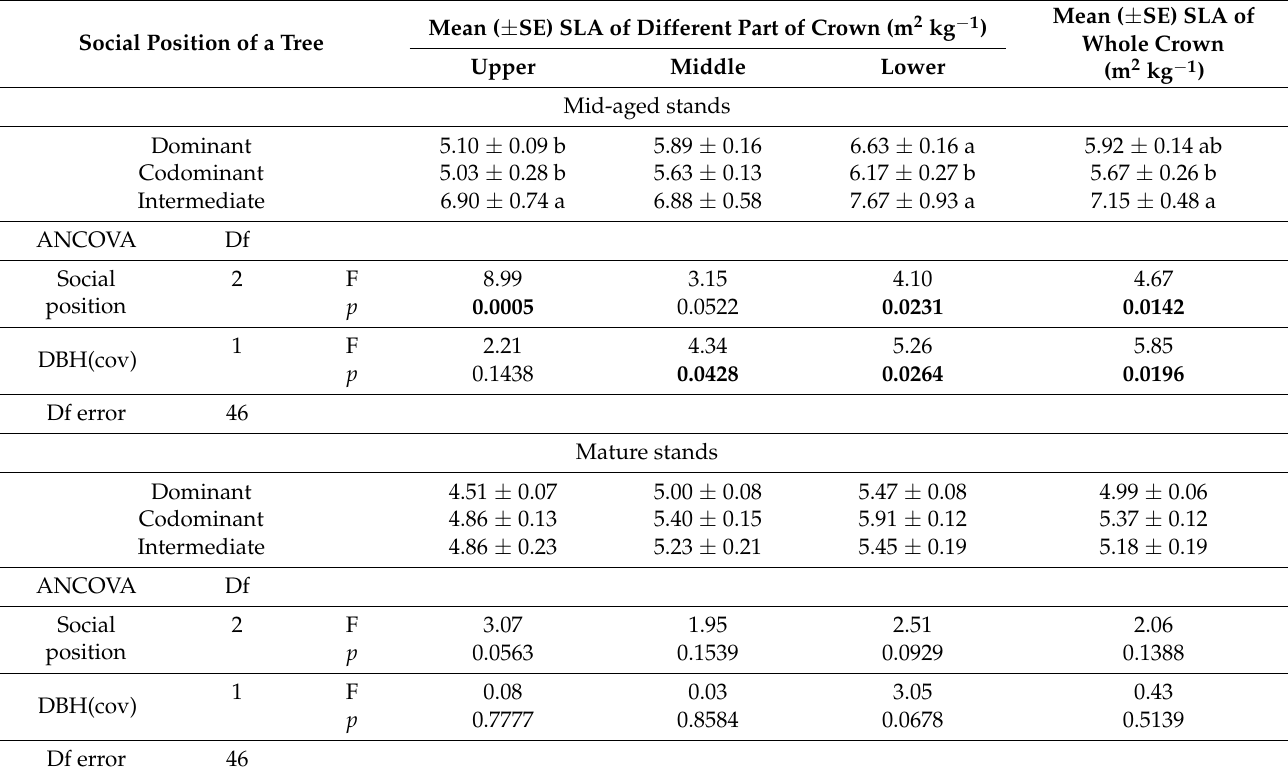
Table 4. The mean SLA of the three parts of the crown (upper, middle, and lower) and the mean SLA of the whole crown for trees of different social positions. Different letters indicate significant differences (Tukey’s honestly significant difference test) between stands of different social positions ( p = 0.05).